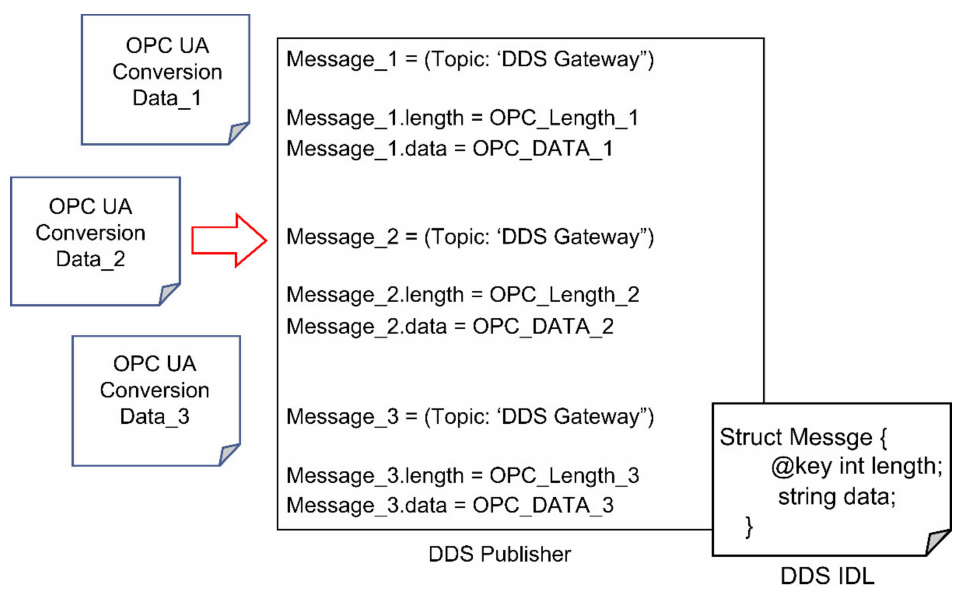
Figure 10. Example of DDS gateway IDL mapping process.